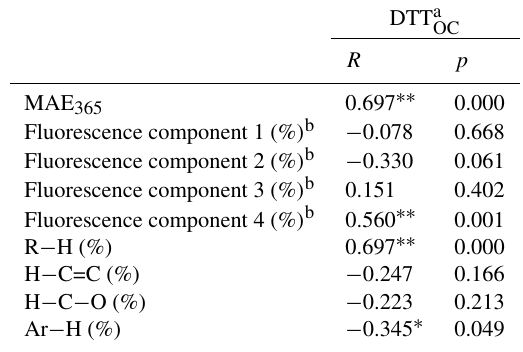
Table 3. Pearson correlation coefficient analysis between oxidation potential and chemical characteristics of